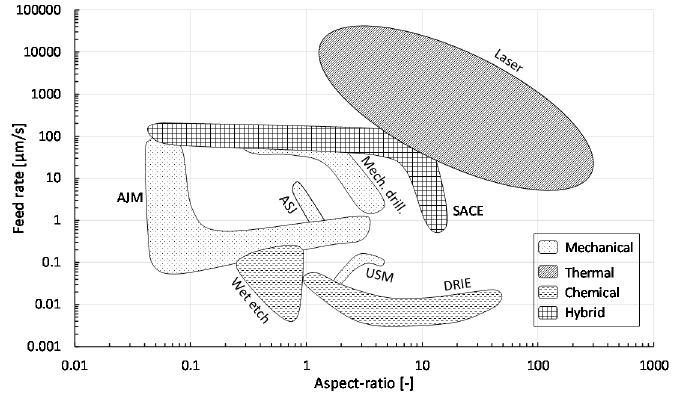
Figure 1. Feed rate ( μ m/s) vs. aspect ratio ( µ m/ µ m) for different glass drilling methods, grouped into four categories (mechanical, thermal, chemical and hybrid). Values in graph based on Table A1. Micromachines 2017 , 8 , 53 12 of 23